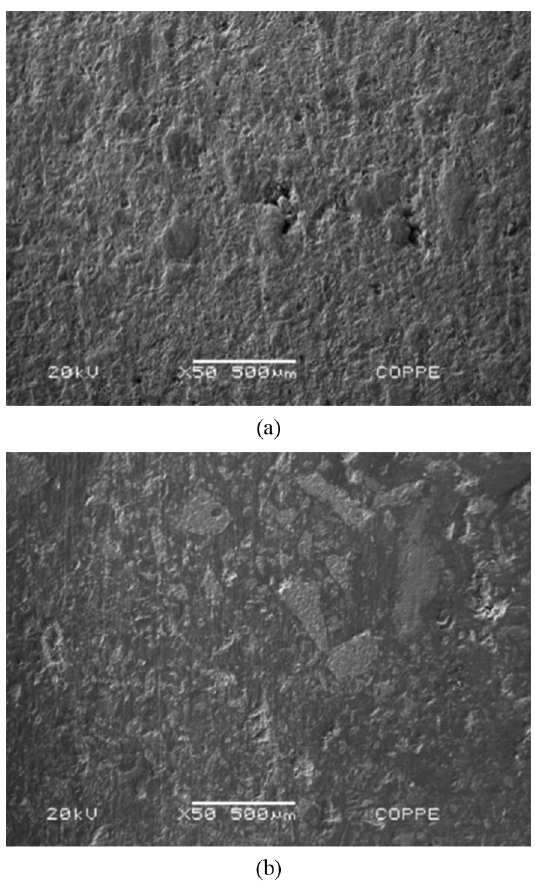
Figure 3. SEM micrograph of the EPRAP 85 (a) and EPRAP 80 (b) polished